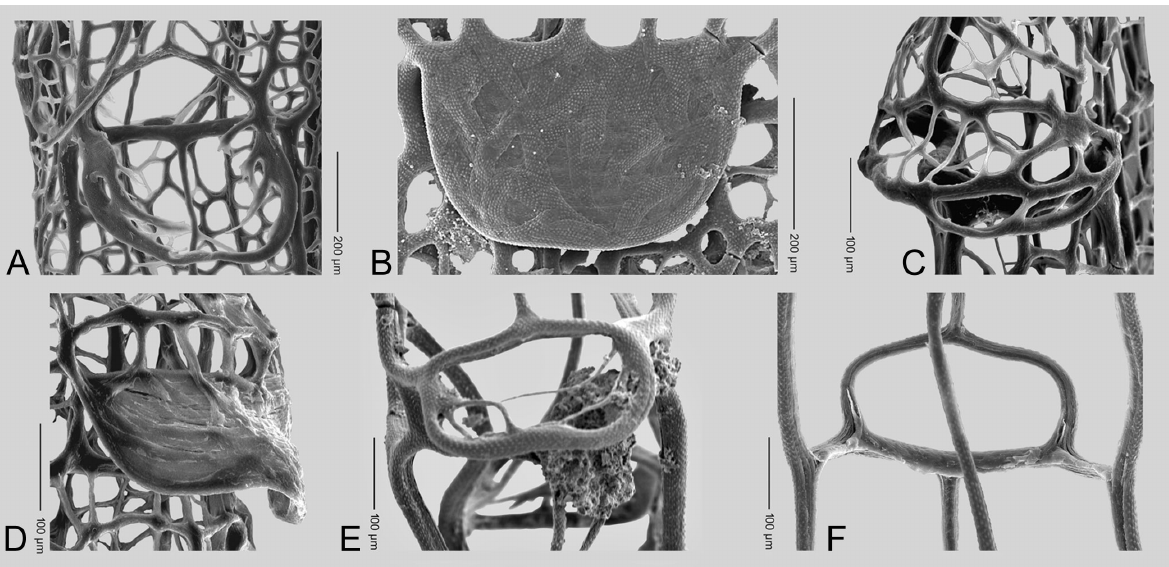
Fig. 2. SEM pictures of apertural hoods of gothograptids: A , reticulated hood of Gothograptus kozlowskii Koz ł owska-Dawidziuk, 1990, ZPAL G.XIII/43, Cyrtograptus lundgreni Biozone, Baltic erratic boulder, Jaros ł awiec, Poland. B , hood of mature specimen, Gothograptus nassa Holm, 1890; Bartoszyce IG-1 core, 1655.8 m, Pristiograptus dubius(cid:150)Gothograptus nassa Biozone. C , reticulated hood, Neogothograptus reticulatus Koz ł owska, Lenz & Melchin, 2009, ZPAL G.41/2, Baltic erratic boulder 59, Jaros ł awiec, Poland. D , solid hood of Neogothograptus eximinassa Maletz, 2008, Baltic erratic boulder from Wetterhammer, Thuringia, Germany, Colonograptus ludensis (cid:150) Monograptus gerhardi Biozone. E , slightly reticulated hood of Neogothograptus balticus (Eisenack, 1951), ZPAL G.27/4, Baltic erratic boulder, Jaros ł awiec 49, Poland. F , thecal aperture from the inside with no hood, Holoretiolites mancki (M(cid:252)nch, 1931), ZPAL G.53/2, Baltic erratic boulder, Jaros ł awiec 48. Figures B, C, D, modified